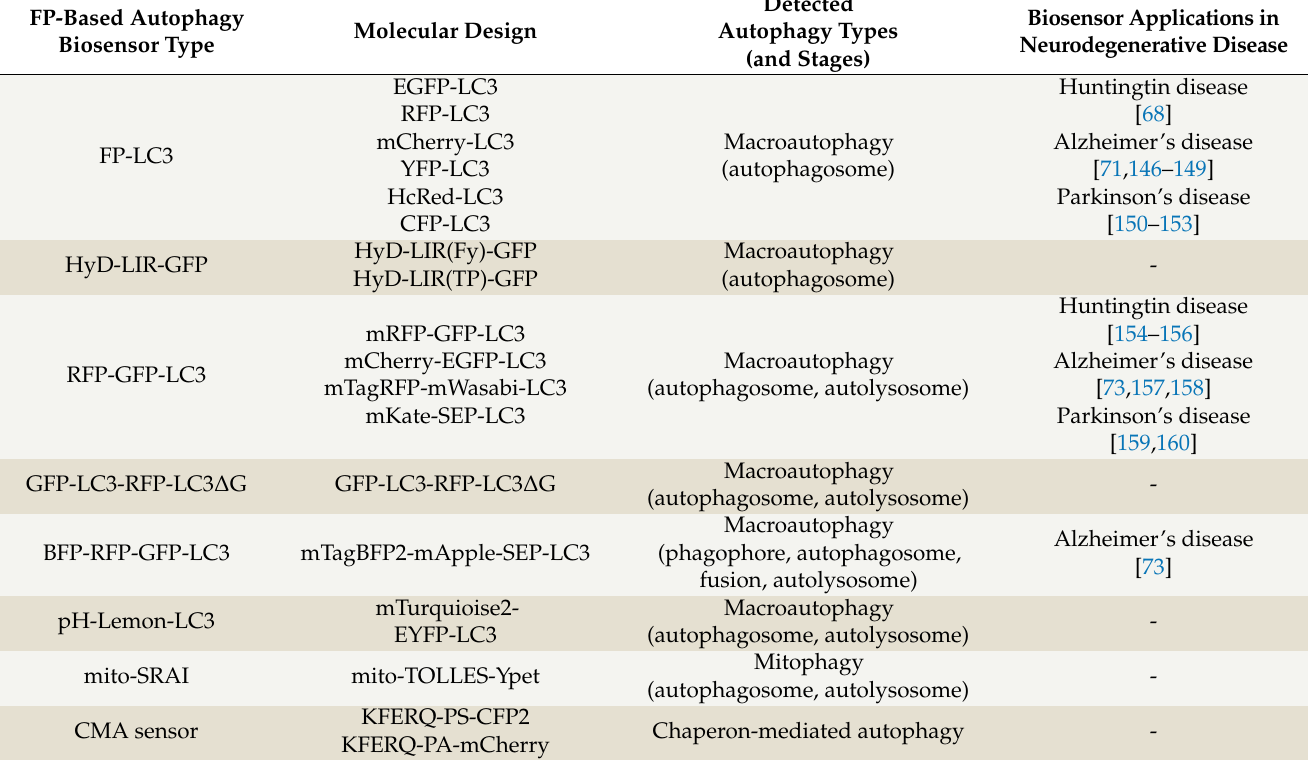
Table 2. FP-based autophagy biosensors and their applications to study neurodegenerative diseases. FP-Based